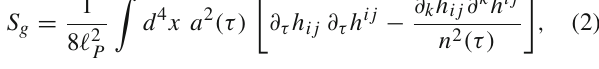
Fig. 1 Thecommonlogarithmeffectivehorizonisapproximatelyillus- trated in terms of the scale factor. The different wavenumbers hit twice the effective horizon and the two crossings determine the slope of the spectrum in a given dynamical